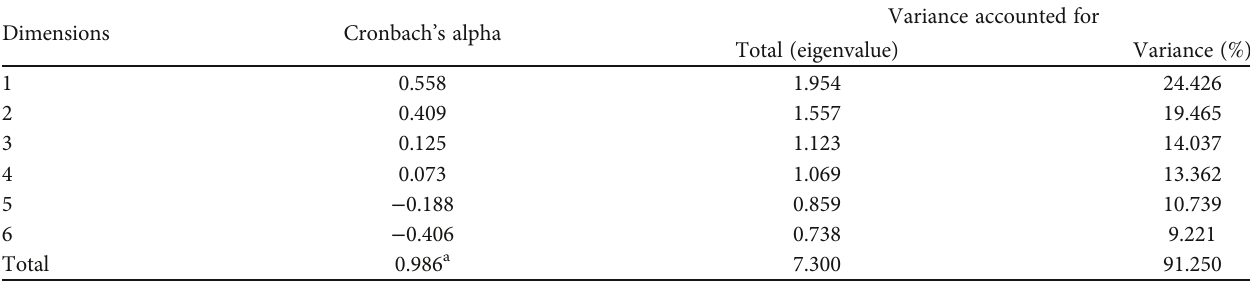
T ABLE 6: Model summary six dimensions.